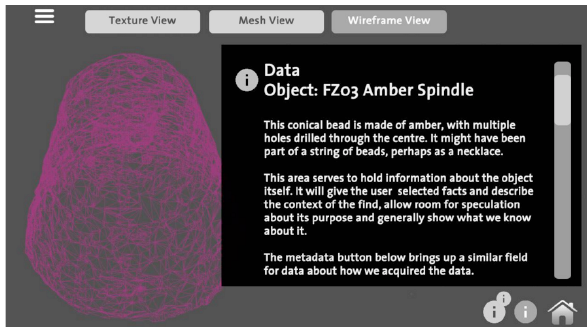
Figure 9. Screenshot for a dissemination app showing a